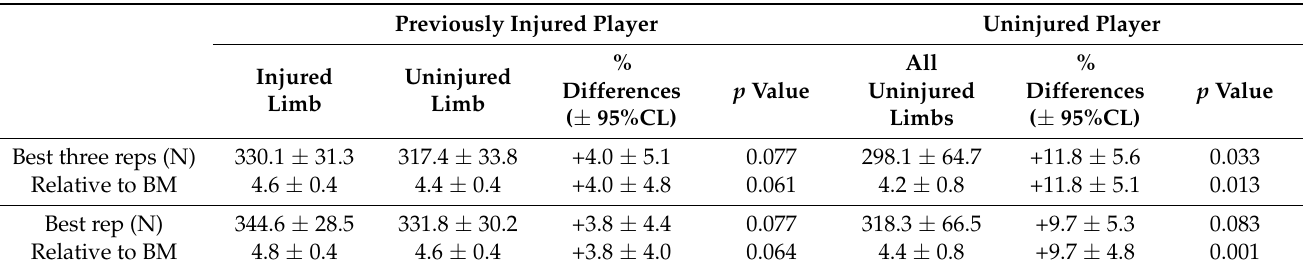
Table 2. Comparisons of knee flexor eccentric strength assessed with the Nordic hamstring exercise between the injured players (i.e., players with a history of a previous injury within the last two competitive seasons) and all uninjured limbs in the uninjured players. Previously Injured Player